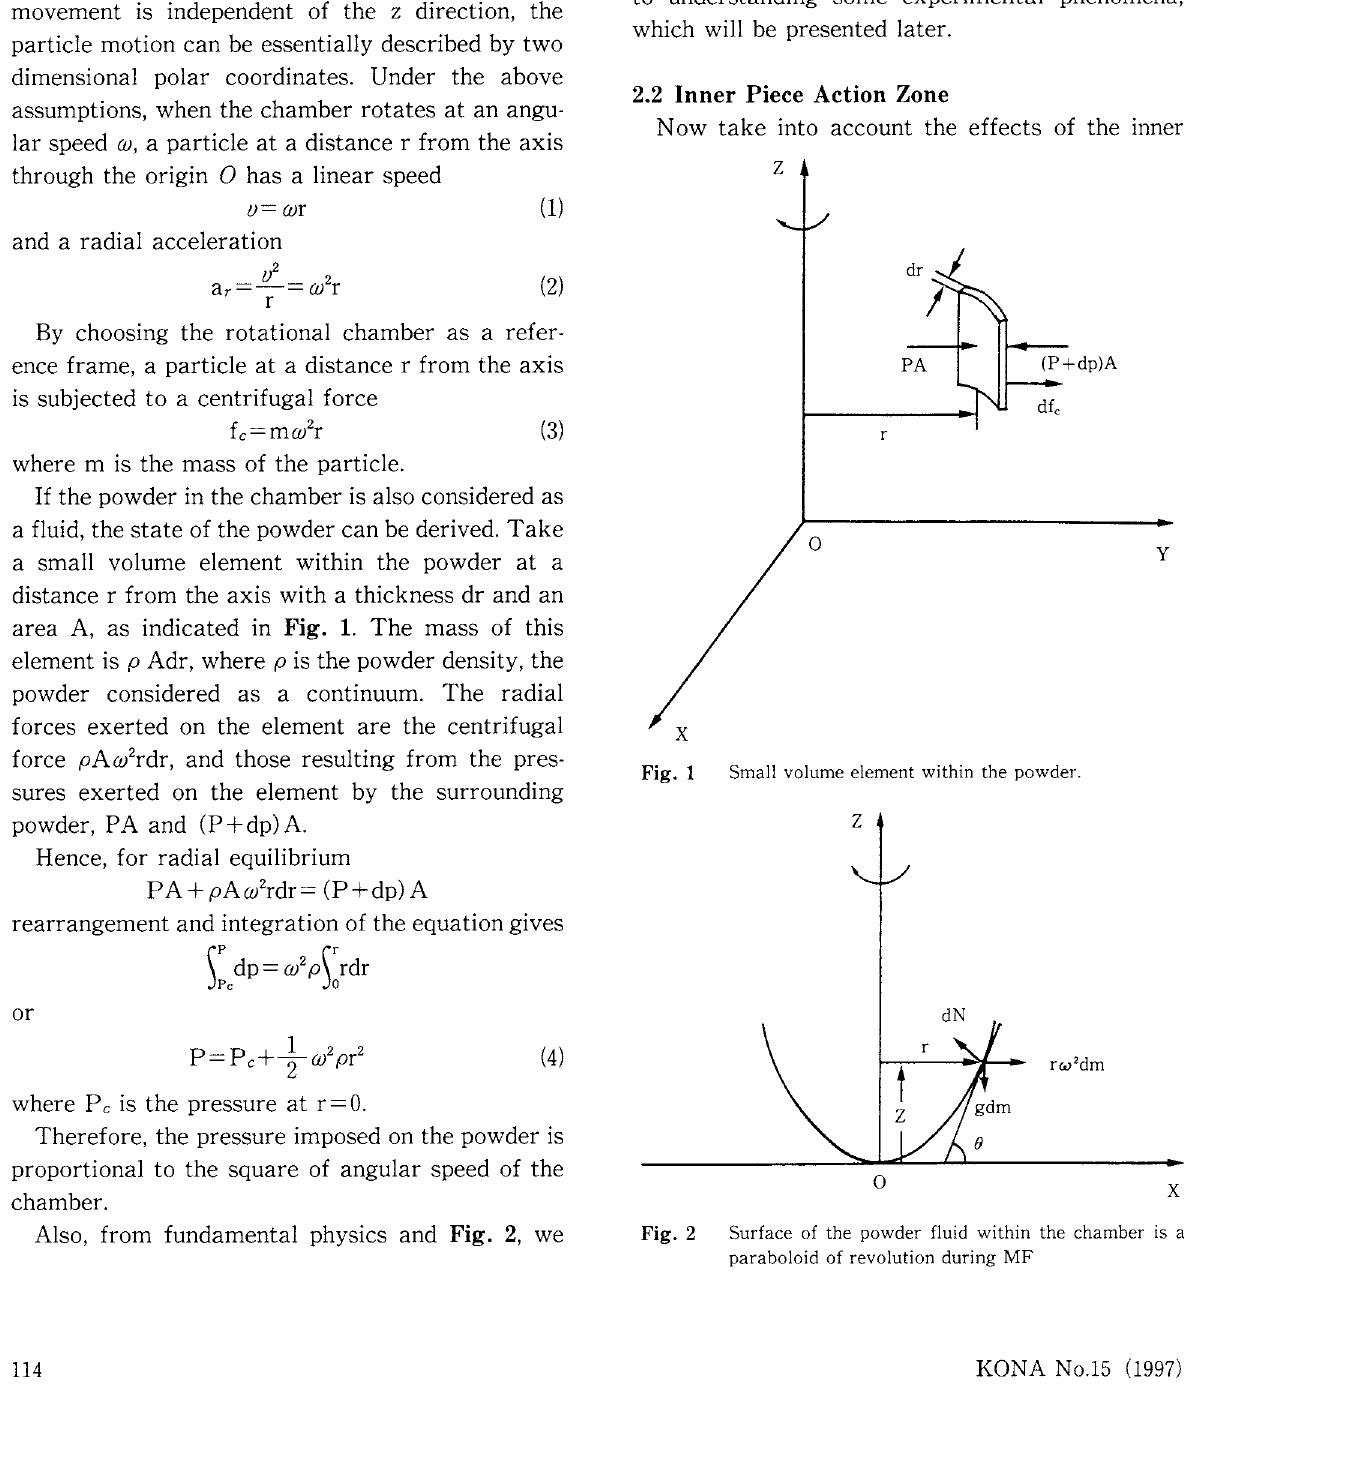
Fig. 2 Surface of the powder fluid within the chamber is a paraboloid of revolution during